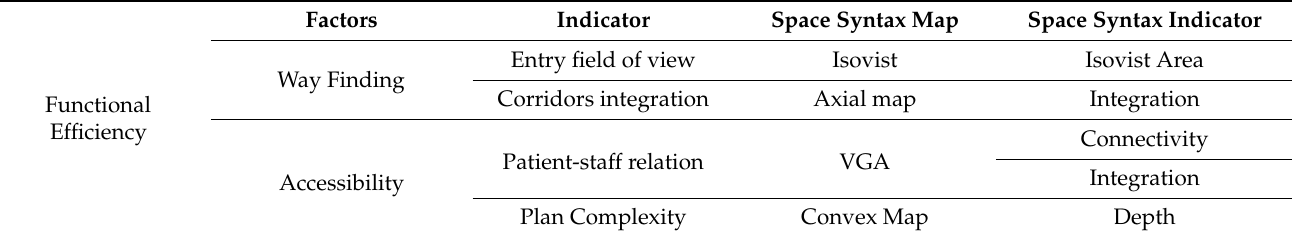
Table 1. Space syntax methods used in the study.